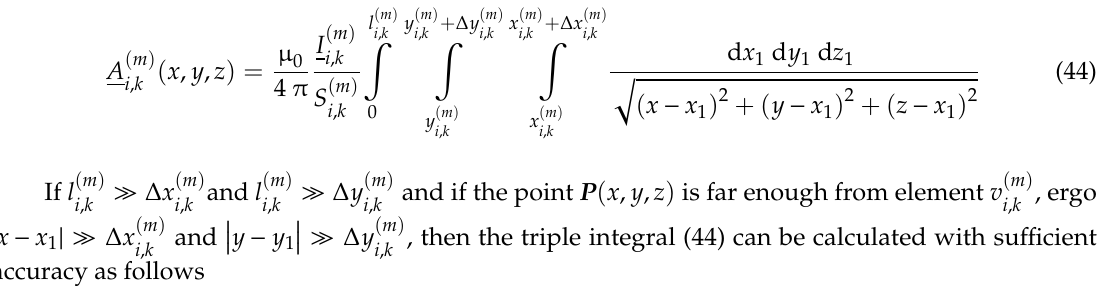
( m ) Figure 8. Location v of the m- th elementary conductor of the i- th phase of the k- th i , k Figure 8. Location 𝑣 (cid:3036),(cid:3038)((cid:3040)) of the m- th elementary conductor of the i- th phase of the k- th conductor. With (42), the component of the magnetic vector potential in the direction of Oz axis is given by the formula